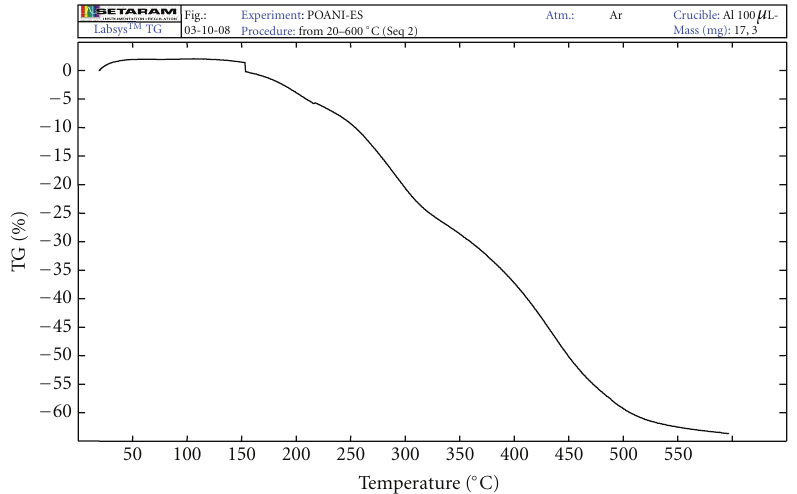
Figure 7: TGA curves of a pure PANI-ES obtained in nitrogen atmosphere at heating rate of 10 ◦ C/min.